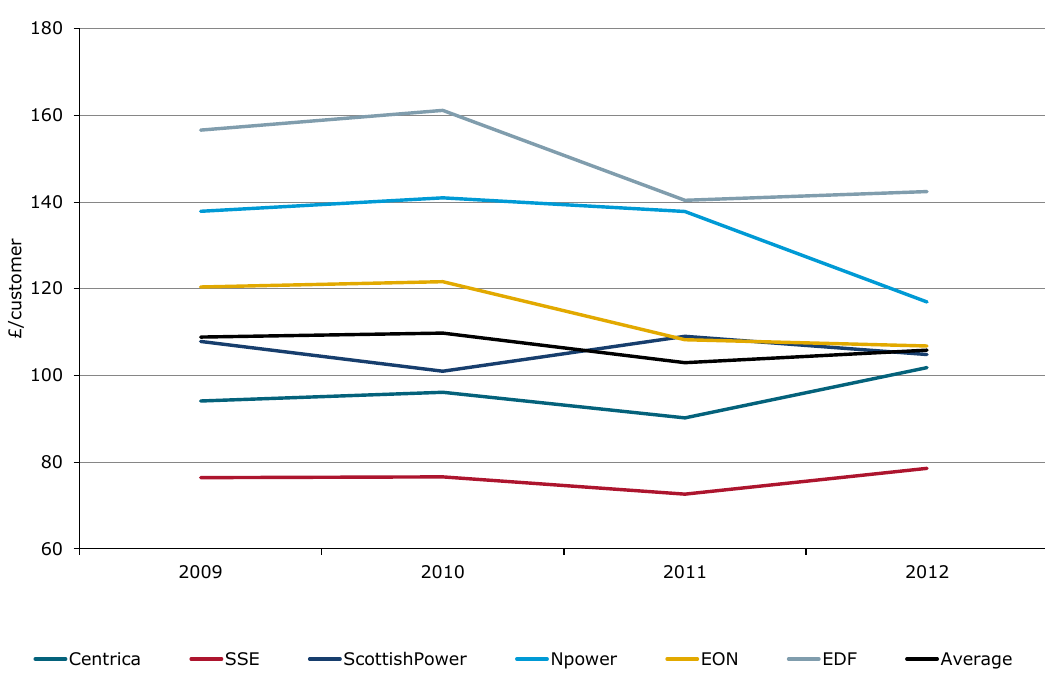
Figure 50: Indirect costs per customer, excluding bad debt and acquisition costs, CPI